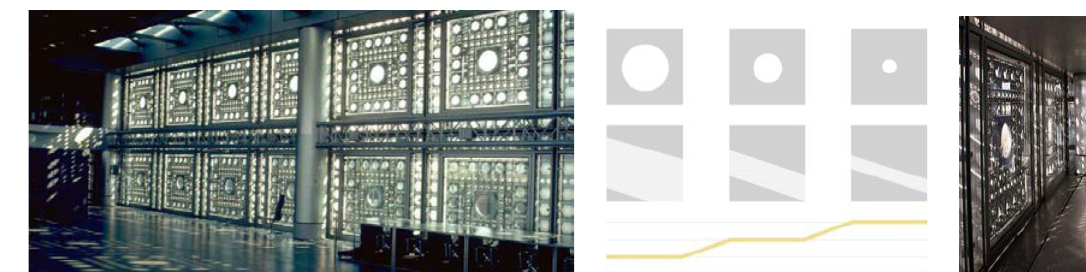
Figure 7: Main concept of Institut du Monde Arabe façade “mushrabiya”, (El-Semary, 2013)